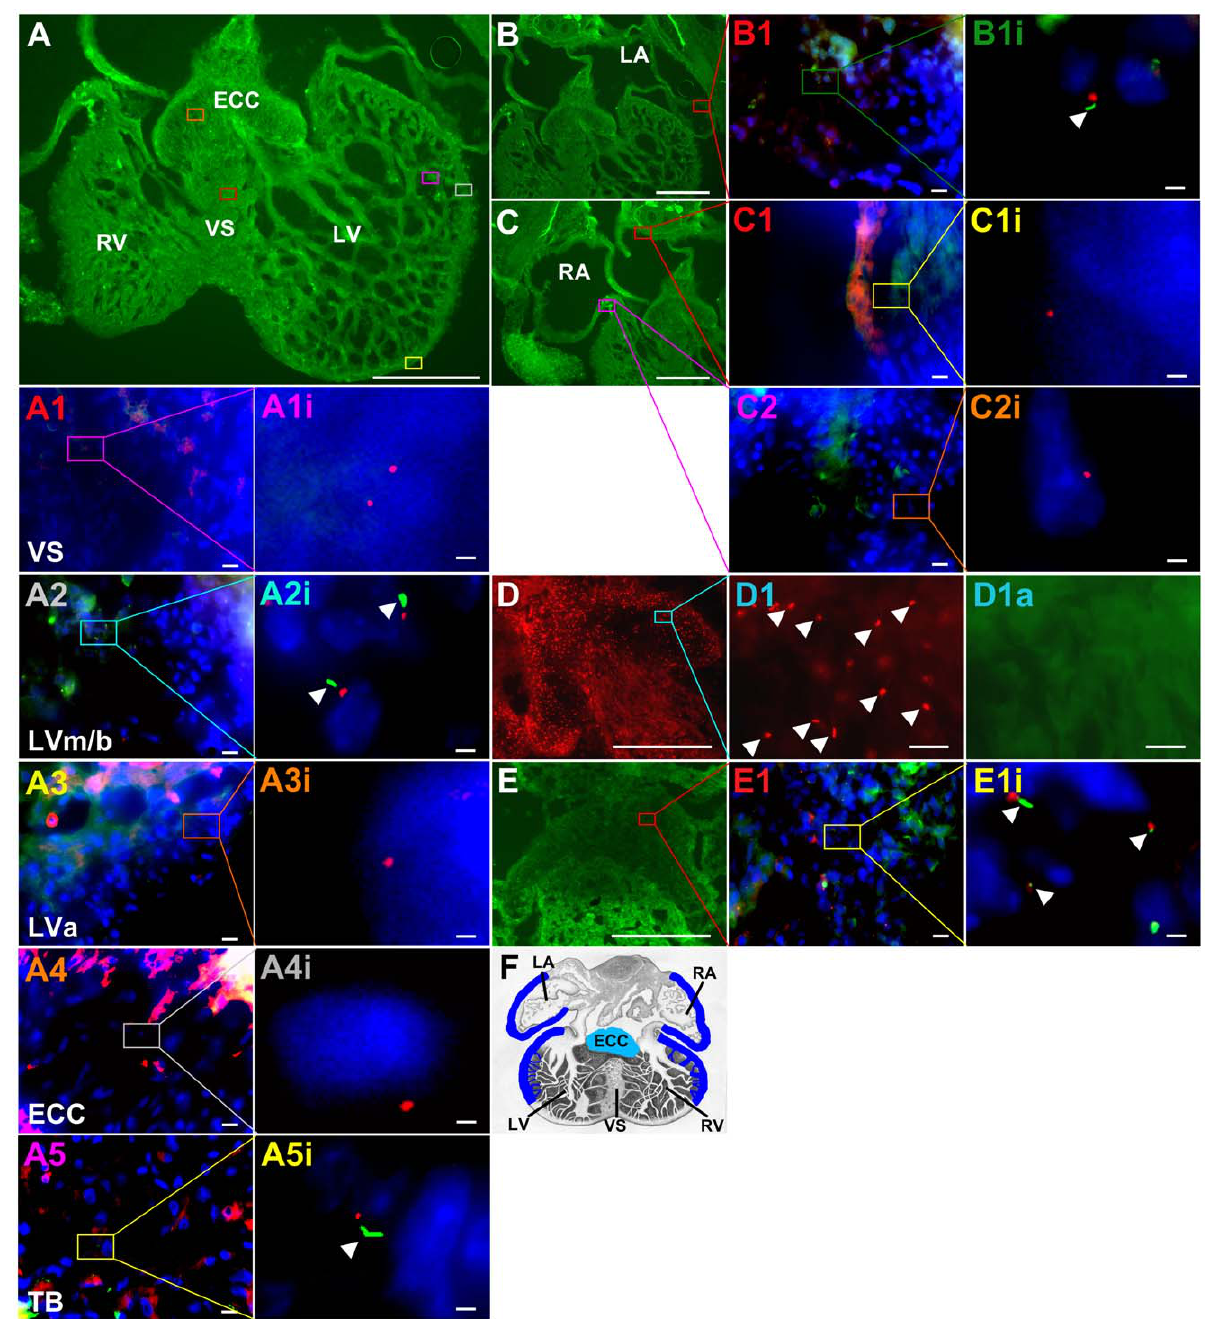
Figure 2. Distribution of primary cilia in murine embryonic hearts. (A, B, C, D, E, A1 2 5, B1, C1 + 2, D1, E1, A1i 2 A5i, B1i, C1i, C2i, D1a, E1i) Immunofluorescence on transverse heart sections at E12.5. (A, B, C) Tubulin cytoskeleton of cardiac cells is stained in green by acetylated a -tubulin resulting in a total view of ventricles (A) and atria (B, C). Cilia are stained in green by acetylated a -tubulin, basal bodies in red by pericentrin and cell nuclei in blue by DAPI (A1 2 5, B1, C1 + 2, A1i 2 A5i, B1i, C1i, C2i). Scale bars (in white) represent a length of 0.5 mm (A, B, C, D, E), 10 m m (A1 2 5, B1, C1 + 2, D1, D1a, E1) or 2 m m (A1i 2 A5i, B1i, C1i, C2i, E1i). (A, B, C, D, E) Coloured squares mark cardiac regions which are presented magnified in A1 2 5, B1, C1 + 2, D1 + 1a and E1. (A1 2 A5, B1, C1 + 2, E1) Coloured squares mark cardiac regions which are shown magnified in A1i-A5i, B1i, C1i, C2i and E1i. (A, B, C, D, E, A1 2 A5, B1, C1, C2, D1, D1a, E1, A1i 2 A5i, B1i, C1i + 2i, E1i) The colour of the square correlates with the colour of the number of the magnified figures. (D) Arl13b is stained in red resulting in a total view of ECCs. (D1) Arl13b staining reveals ciliary presence on ECCs, while these cilia cannot be detected by staining acetylated a -tubulin in green (D1a). (E) Tubulin cytoskeleton of cardiac cells is stained in green by detyrosinated tubulin resulting in a total view of the ECCs. (E1, E1i) Cilia are stained in green by detyrosinated tubulin, basal bodies in red by c -tubulin and cell nuclei in blue by DAPI. (F) Schematic illustration of ciliary distribution in embryonic mouse hearts. We found cilia exclusively at E10.5–12.5 and solely in distinct ventricular and atrial regions (blue lines) and on ECCs (turquoise staining). ECC, endocardial cushion cells; LA, left atrium; RA, right atrium; LV, left ventricle; LVa, left ventricle apical; LVm/b left ventricle medial/basal; RV, right ventricle; TB, trabecular formations; VS, ventricular septum.